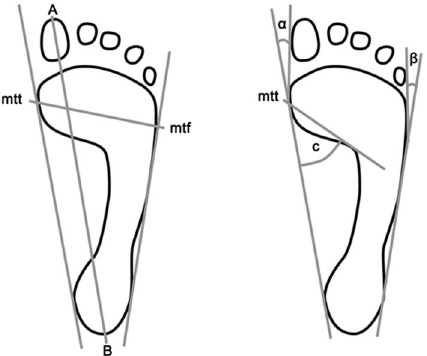
Figure 5. The method of determining the foot variables under study. A-B—foot length, mtt-mtf-foot width, C—Clarke’s angle, α—hallux valgus angle, β—varus deformity of the 5th toe. (Source: Own research 21 . “Feet deformities and their close association with postural stability deficits in children aged 10–15 years,“ by Szczepanowska-Wolowiec et al. 21 Copyright 2019 by the